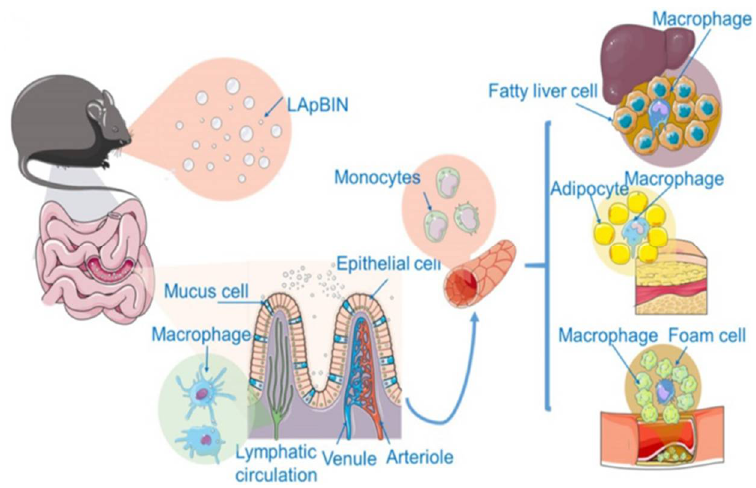
Figure 4. Schematic diagram of LAM-mediated oral targeting of nanoparticles to diseased sites of obesity-related diseases distant from the gastrointestinal tract. Reproduced with permission [140].